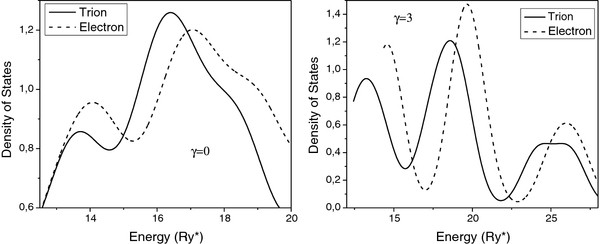
The same as in Figure3 but for disk-shaped QDs.